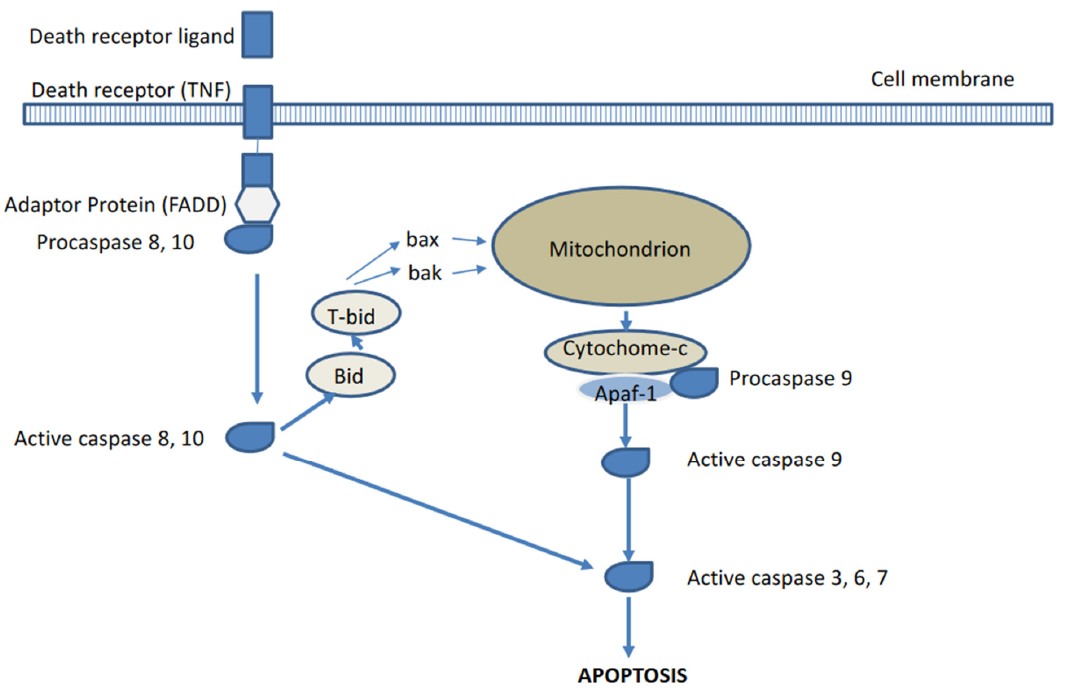
Figure 1. Extrinsic and intrinsic pathways of apoptosis activation.